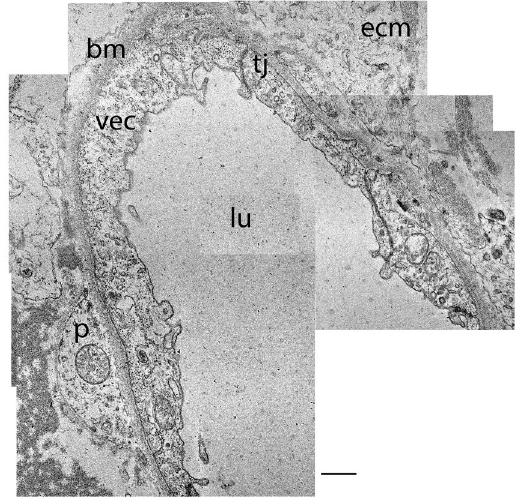
Figure 2. The BLB in the macula utricle from a normal subject, older age (86-year-old female). Note the normal appearance of the VECs (vec), the basement membrane (bm), extracellular matrix (ecm), tight junctions (tj), and capillary lumen (lu) are also normal. The pericyte (p) cytoplasm appears normal. Bar = 2.5 μ